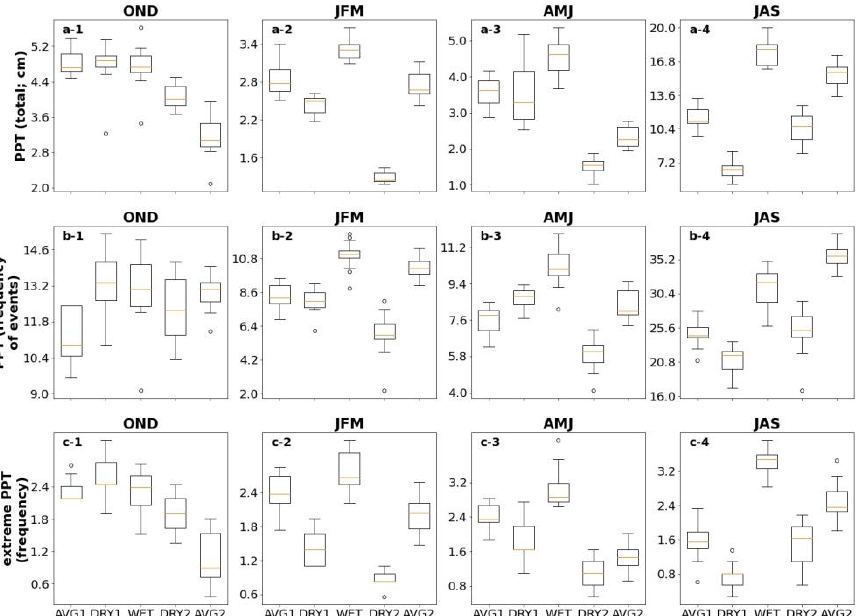
Figure 10. Period average of annual precipitation metrics by season: fall (OND), winter (JFM), spring (AMJ), and summer (JAS). Boxplots represent the distribution of values at the 16 locations. ( a-1 – a-4 ) Total precipitation (cm), ( b-1 – b-4 ) frequency of precipitation exceeding 0.01 cm/day (% of days), and ( c-1 – c-4 ) frequency of precipitation exceeding the 98th percentile (% of days). Letters indicate significantly different means in the five-way comparison of periods. Vertical scales differ by season for each precipitation metric.